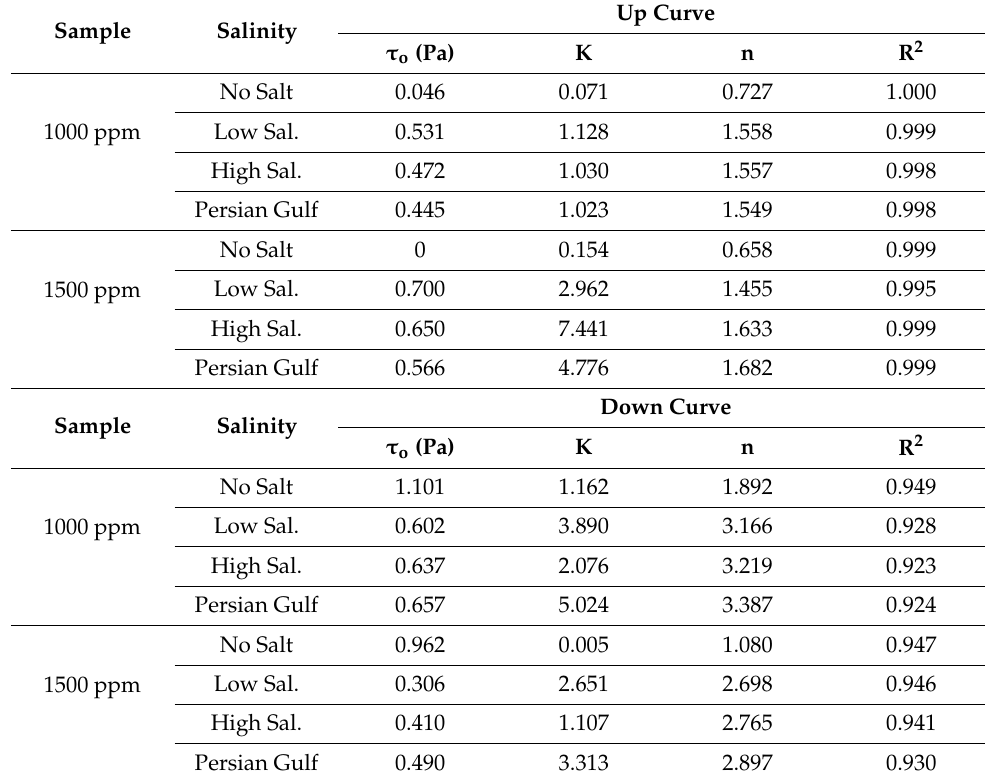
Table 6. Parameters of Herschel–Bulkley model for B192 polymer